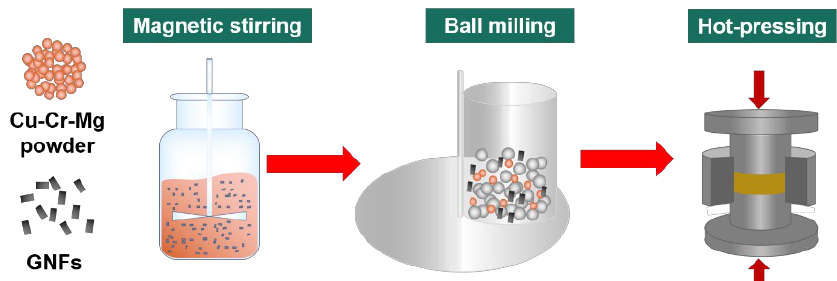
Figure 1. Preparation process of the GNPs /Cu–Cr–Mg composite.